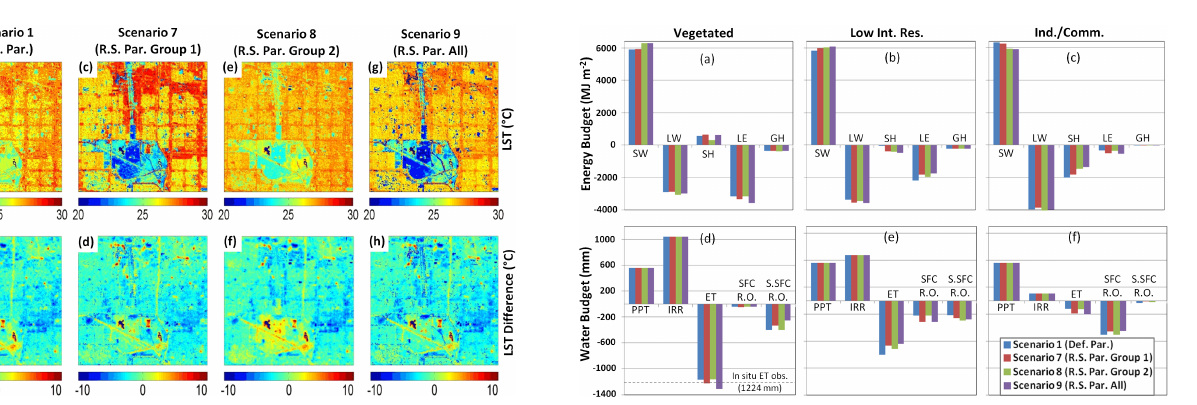
Figure 7. Differences in simulated energy (top) and water (bottom) budgets for WY 2011, using different urban surface parameteri- zation and averaged over different land cover types. Energy bud- get terms include shortwave radiation (SW) and longwave radia- tion (LW), as well as sensible (SH), latent (LH), and ground (GH) heat fluxes. Water budget terms include precipitation (PPT), irri- gation water (IRR), evapotranspiration (ET), surface runoff (SFC R.O.), and subsurface runoff (S. SFC